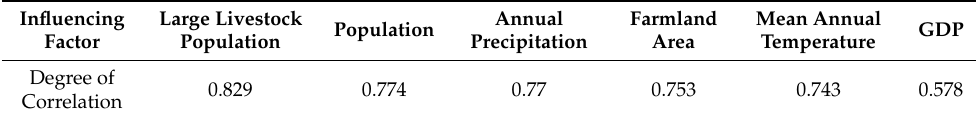
Table 3. Degree of correlation between hydrological connectivity and possible driving